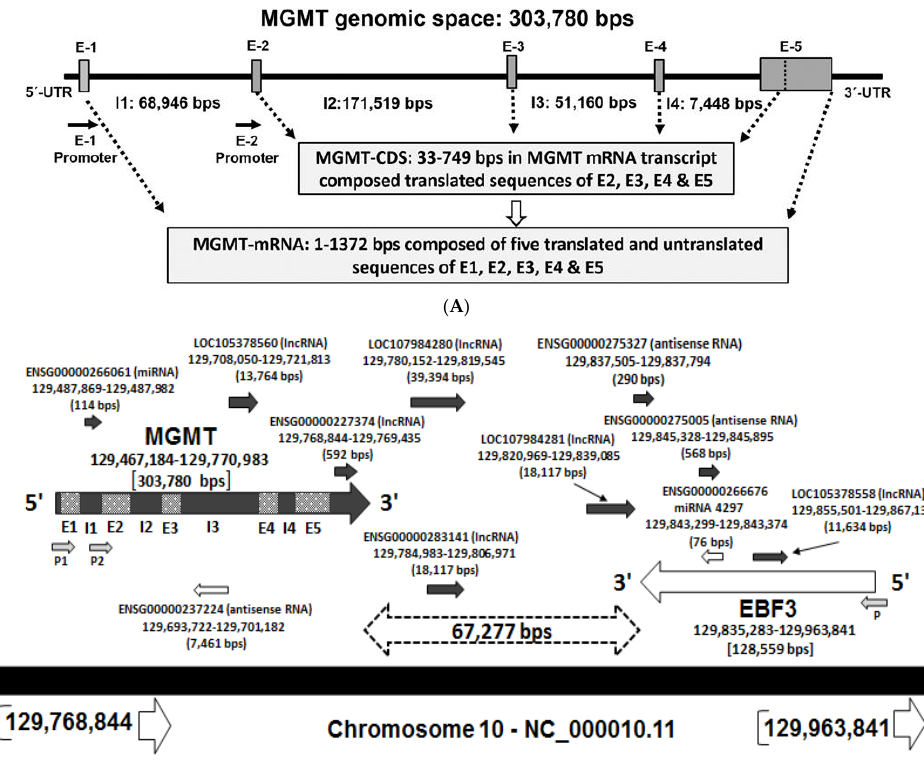
Figure 1. ( A )— MGMT genomic space showing the two untranslated regions 5’-UTR and 3’-UTR, the five exons (E1-E5), four introns (I1–I4), two promoters ( MGMT-E1 and a putative MGMT-E2 promoter identified in this report), and the cod- ing sequence of MGMT mRNA transcript NM_002412. ( B )—Schematic presentation of the MGMT-EBF3 genomic region along with ncRNA loci (miRNA, lncRNA, and antisense RNA) hosted in this space. Black arrows show the loci in the 5’– 3’ direction on the forward strand. The white arrows indicate the loci in the 5’–3’ direction on the reverse strand. The bidirectional dotted arrow shows the space between MGMT and the EBF3 genes. Letters “E” and “I” refer to exons and introns in the MGMT genomic space denoted by small light and dark gray boxes. P1 refers to the well-studied MGMT promoter proximal to exon-1. Our bioinformatic analysis showed the presence of a promoter-like sequence (indicated as P2) in the intron 1-exon 2 regions. LOC and ENSG refer to the loci IDs in the GenBank-Gene and Ensembl databases.